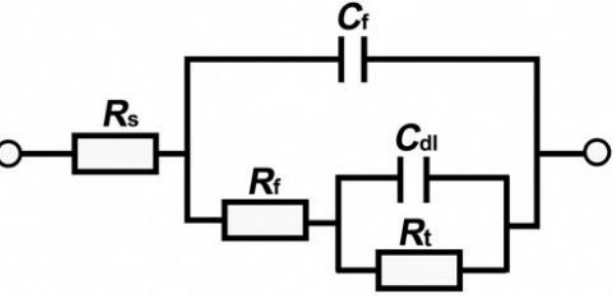
Figure 11. Equivalent circuit models for the corrosion system of 310S stainless steel in different concentrated solutions [11].